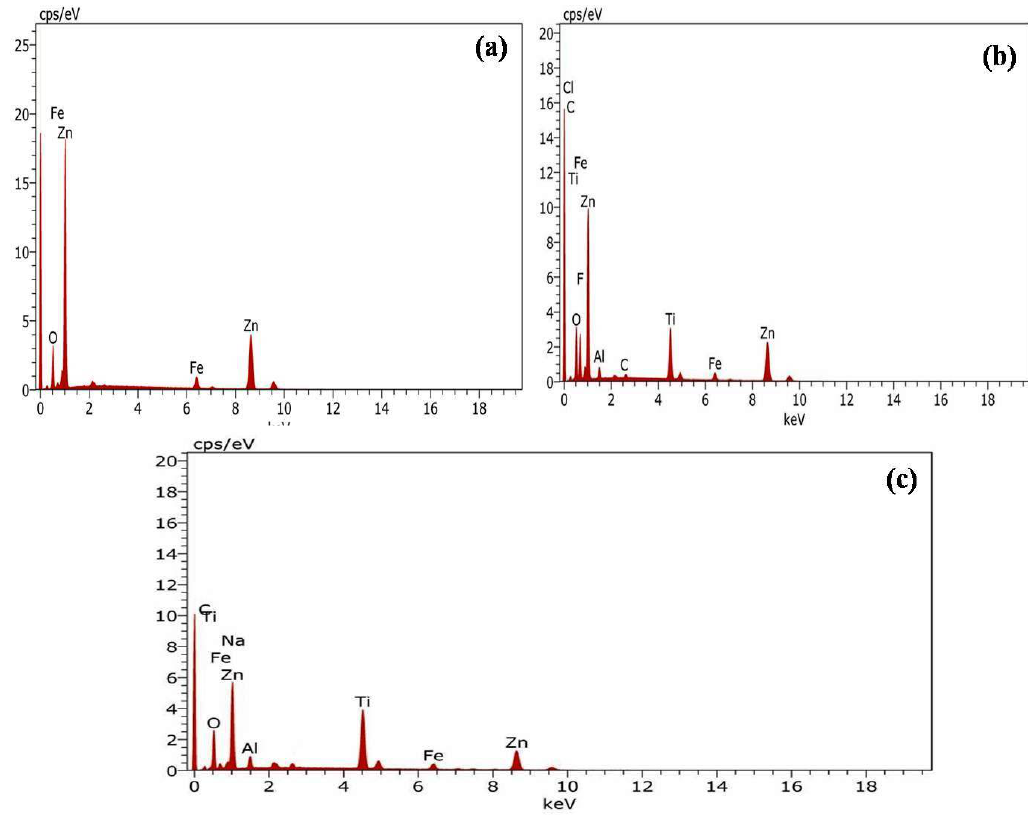
Figure 3. EDAX spectrum for the ( a ) ZnO-Fe, ( b ) ZnO-MXene, and ( c ) ZnO-Fe-MXene nanocomposites.